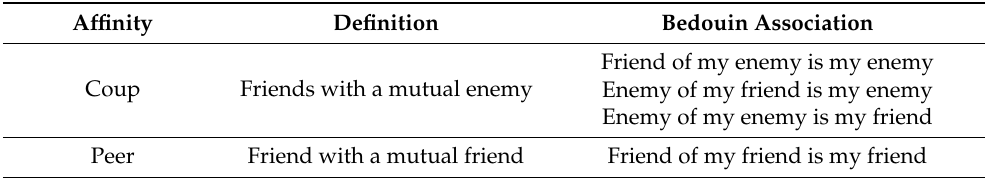
Table 2. Bedouin